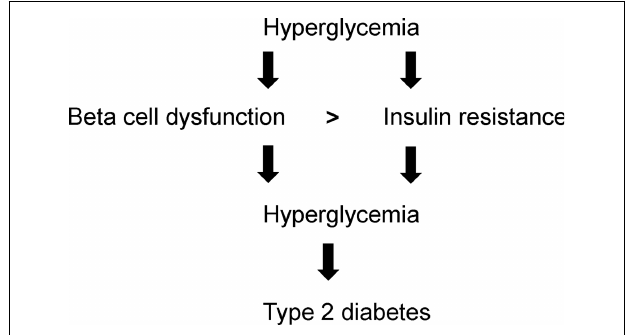
FIGURE 1 | Hyperglycemia-induced beta cell dysfunction, insulin resistance, and type 2